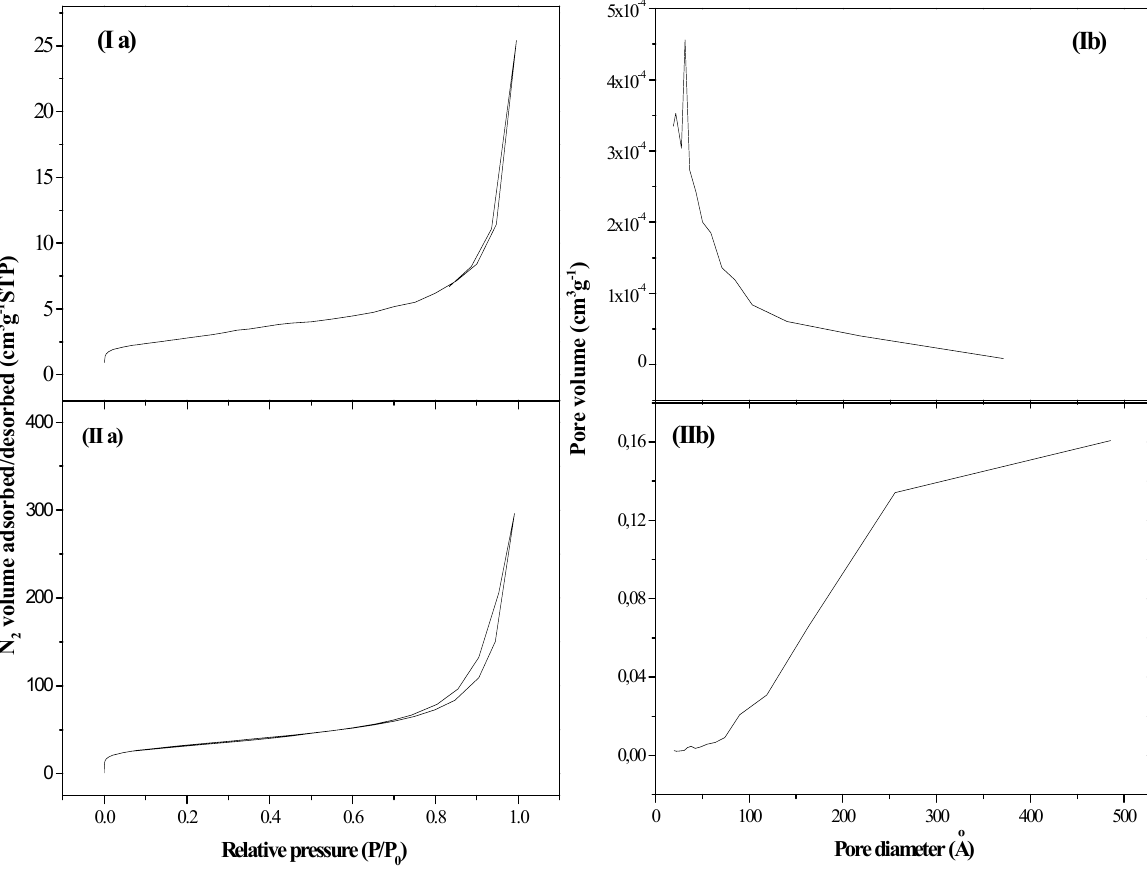
Figure 1. ( a ) N adsorption/desorption isotherms and ( b ) pore size distributions associated 2 to ( I ) G and ( II )